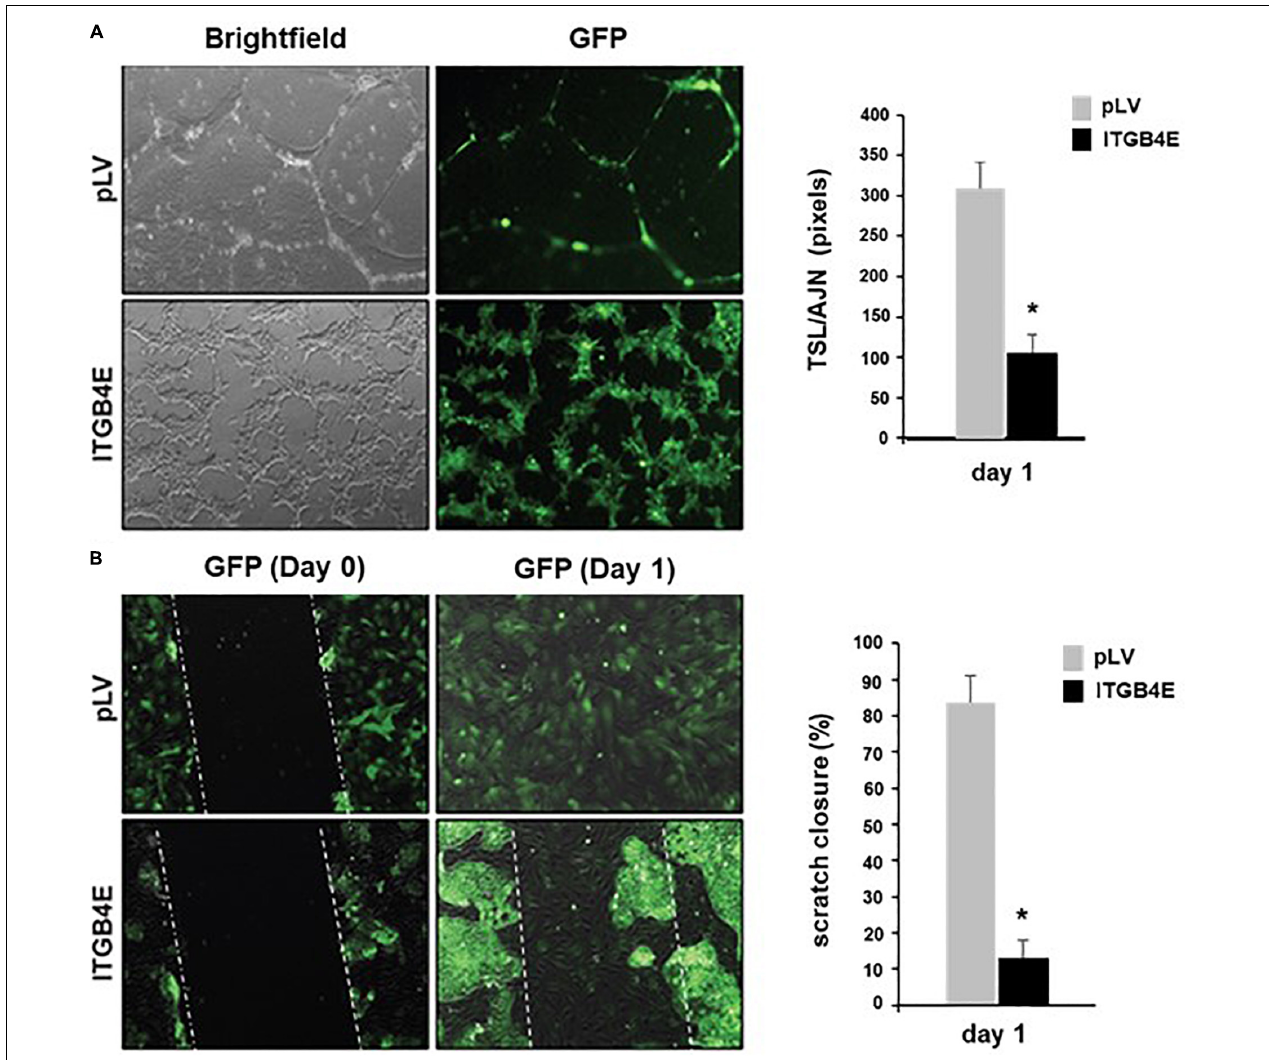
FIGURE 3 | ITGB4E overexpression is associated with dysregulated EC angiogenesis and migration. (A) Human pulmonary artery ECs were transfected with ITGB4E or control vector and then grown in Matrigel. Images were then taken on day 1 to assess changes associated with angiogenesis (representative images shown). Quantitation of endothelial tube formation was performed and expressed as total segment length (TSL) relative to the number of anchorage joints (AJN) (* p < 0.01, n = 3 independent experiments). (B) In separate experiments, transfected cells were grown to confluence and used for scratch assay to assess migration. Images of cells overexpressing ITGB4E and controls were taken on days 0 and 1 (representative changes shown). Quantitation of relative gap closure on day 1 was performed and expressed as a percentage of the initial gap width on day 0 (* p < 0.01, n = 3 independent